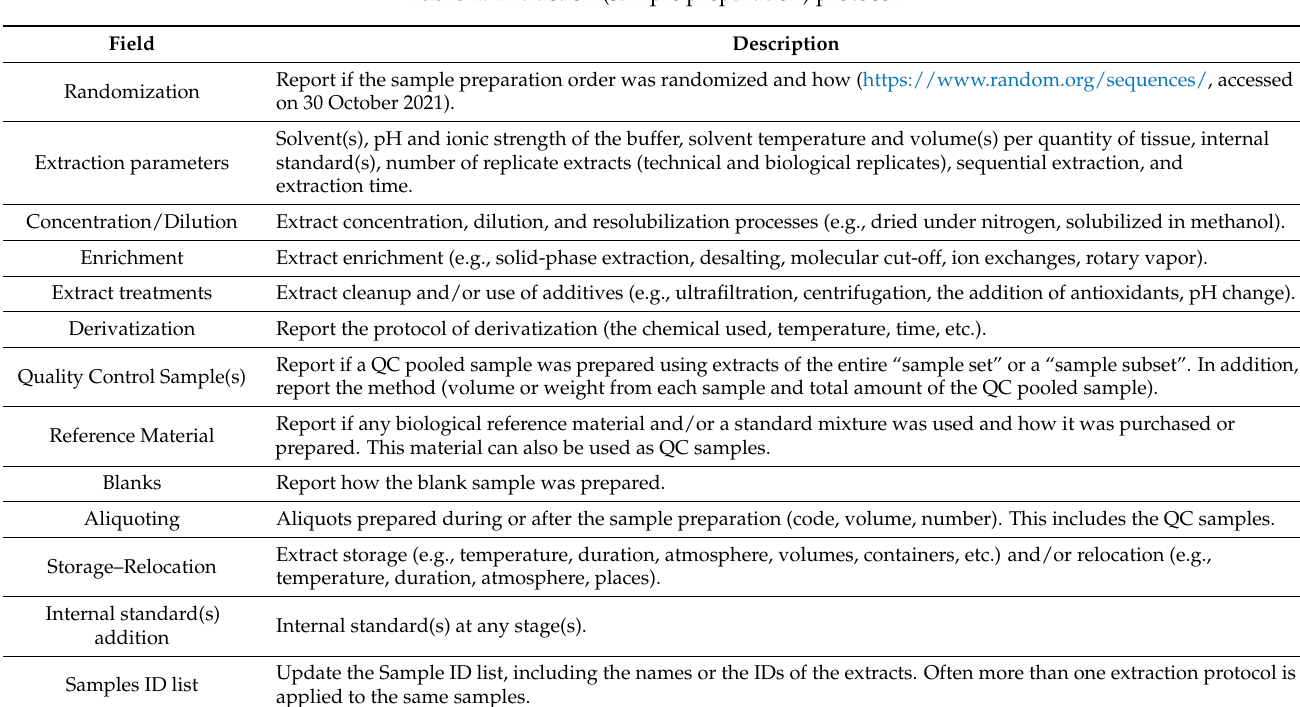
Table 2. Extraction (sample preparation)